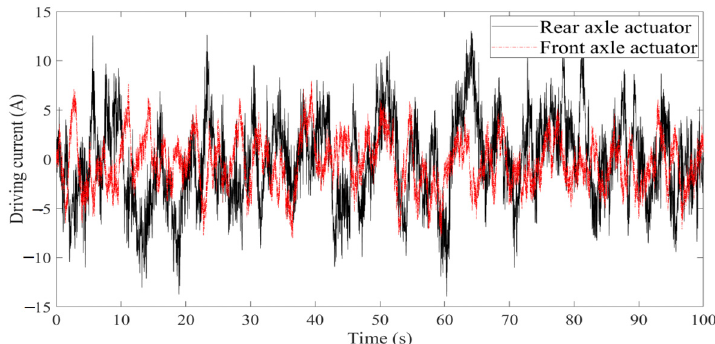
Figure 8. Drive current of active suspension actuators.